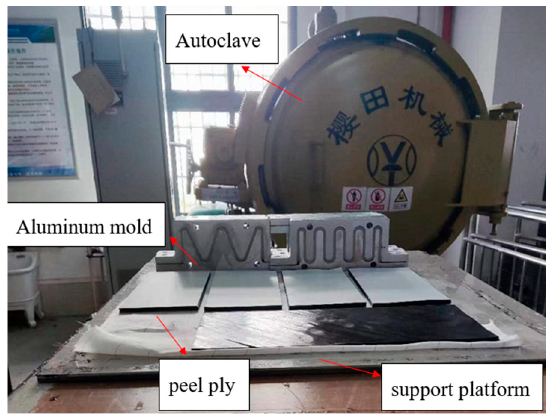
Figure 2. Preparation process of GFRP wave springs.